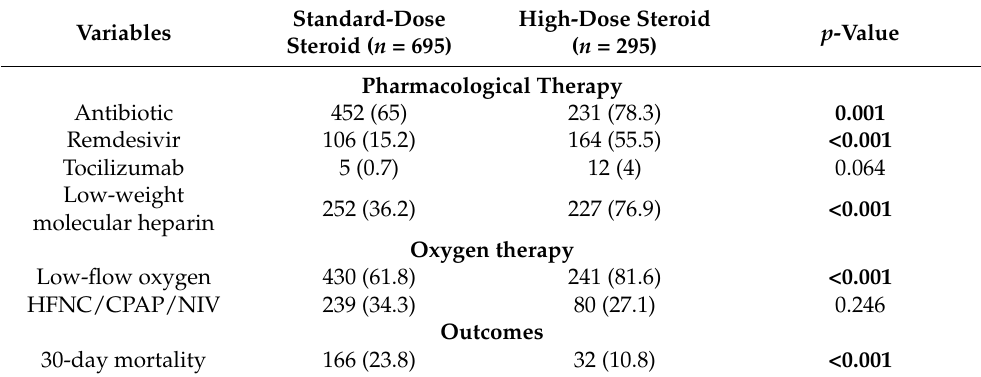
Table 3. Therapy and outcome parameters of COVID-19 patients treated with standard- or high-dose of steroids.